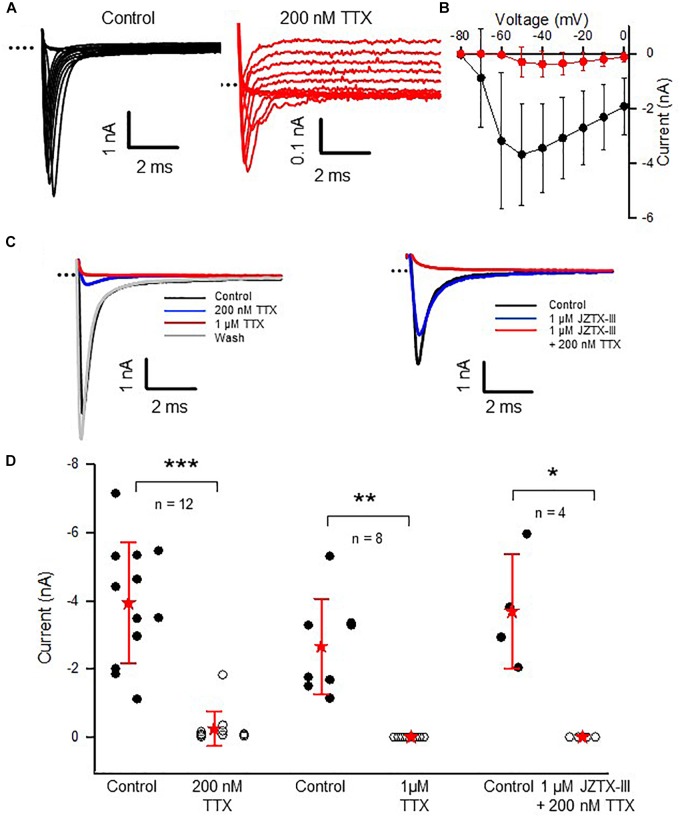
A TTX-insensitive current is present in immature calyces. (A) Control INa and currents remaining in the presence of 200 nM TTX at membrane potentials above –60 mV in a P8 calyx (note different current scales for left and right panels). Voltage protocol similar to Figure 2: a 40 ms step to –130 mV from a holding potential of –80 mV was followed by a series of 40 ms depolarizing steps in 10 mV increments from –90 to +20 mV. (B) Control (black) and response to 200 nM TTX (red) for nine calyces (P5–11) are shown in the IV plot of peak inward currents for steps between –80 and 0 mV. (C) Left panel: the residual current following 200 nM TTX is blocked in 1 μM TTX and the block reverses with washout in a P6 calyx. Currents in response to a voltage step from –130 to –30 mV. Right panel: 1 μM JZTX-III blocks a component of INa and the remaining current is abolished following application of 1 μM JZTX-III plus 200 nM TTX in a P7 calyx. Currents in response to a voltage step from –130 to –50 mV. (D) Summary for a group of 12 cells perfused with 200 nM TTX (six cells at P5–6, six at P8–11). A group of cells exposed to 1 μM TTX (n = 8, one cell at P6, seven cells at P7–10) INa was abolished in 1 μM JZTX-III and 200 nM TTX (n = 4, two cells at P6 and two cells at P7). Peak inward current was measured at –50 mV step. INa tended to be larger at younger ages as shown by distributions. In the presence of 200 nM TTX, INa decreased from –3.9 (1.8) to –0.25 (0.5) nA (P < 0.001, paired t-test, n = 12). Remaining INa ranged from 0.008 to 1.8 nA. In all cells exposed to 1 μM TTX, INa was completely abolished (n = 8, P = 0.001). INa was also completely abolished in a group of cells perfused with a combination of 1 μM JZTX-III and 200 nM TTX (n = 4, P = 0.022). External solution was L-15 in the TTX experiments, and 80 mM Na+ HEPES in the JZTX-III/200 nM TTX experiments; electrode solution Cs+. ∗∗∗P < 0.001, ∗∗P < 0.01, ∗P < 0.05.